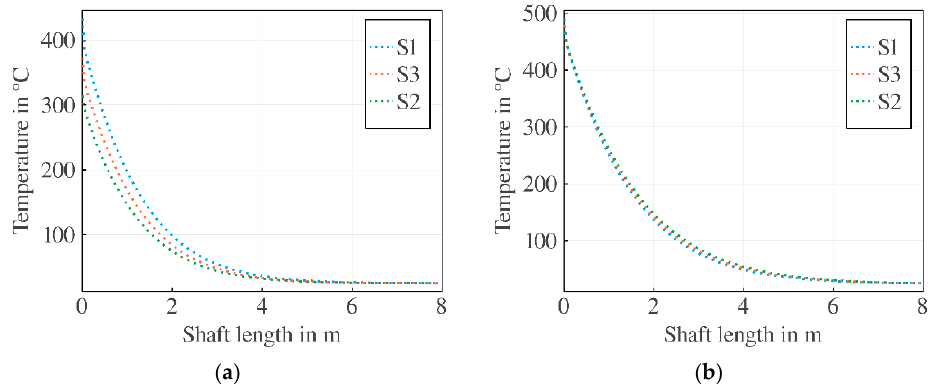
Figure 11. Simulated temperature distribution over the scrap bulk after ( a ) 5 and ( b ) 50 min.